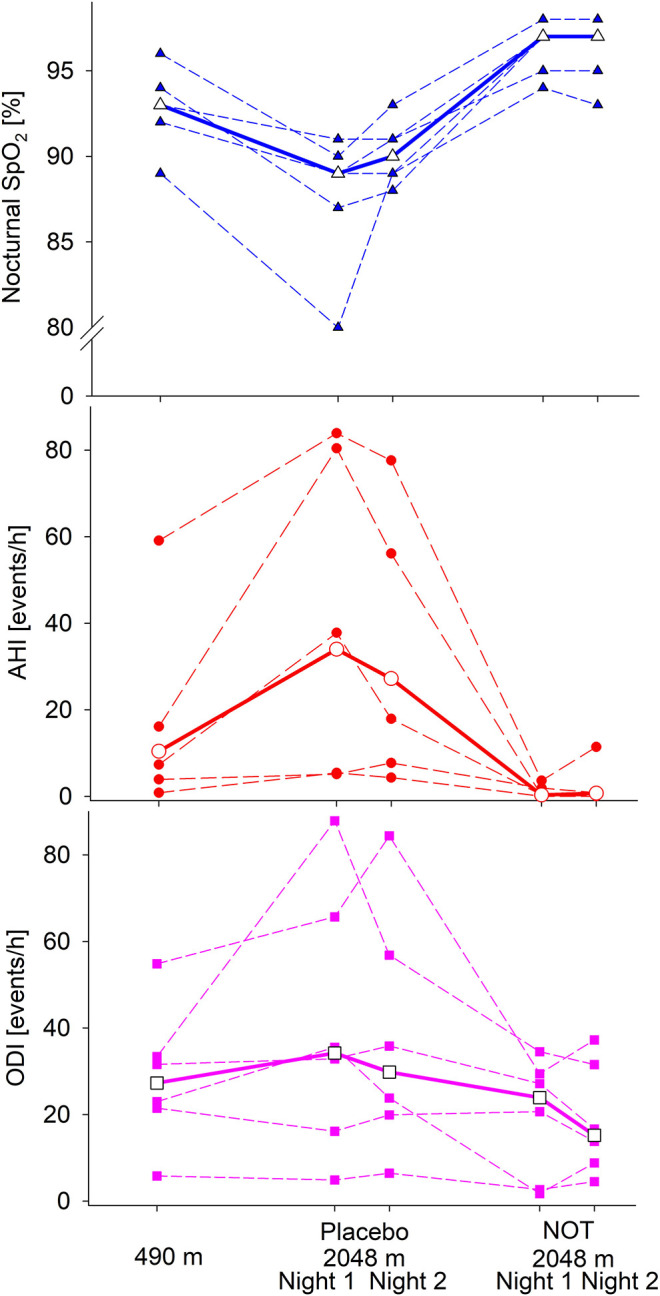
Six-minute walking distance (6 MWD) and oxygen saturation (SpO2) at the beginning and end of the 6 MWD of the patients who completed the study. Bold, median.